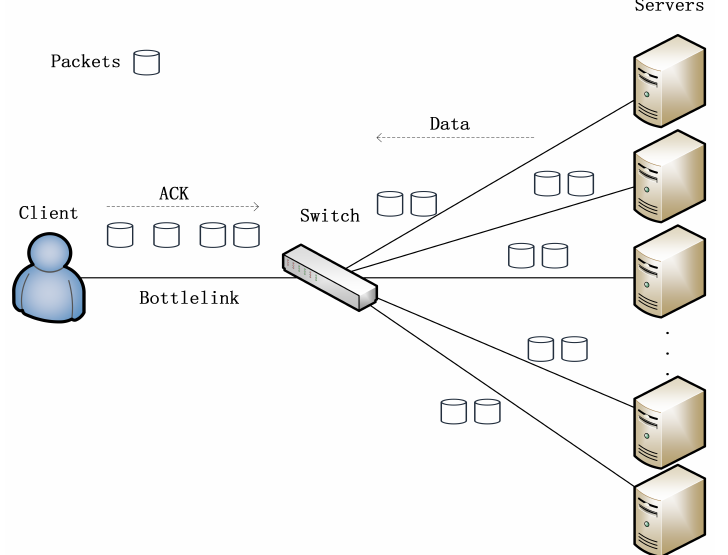
Figure 1. TCP incast